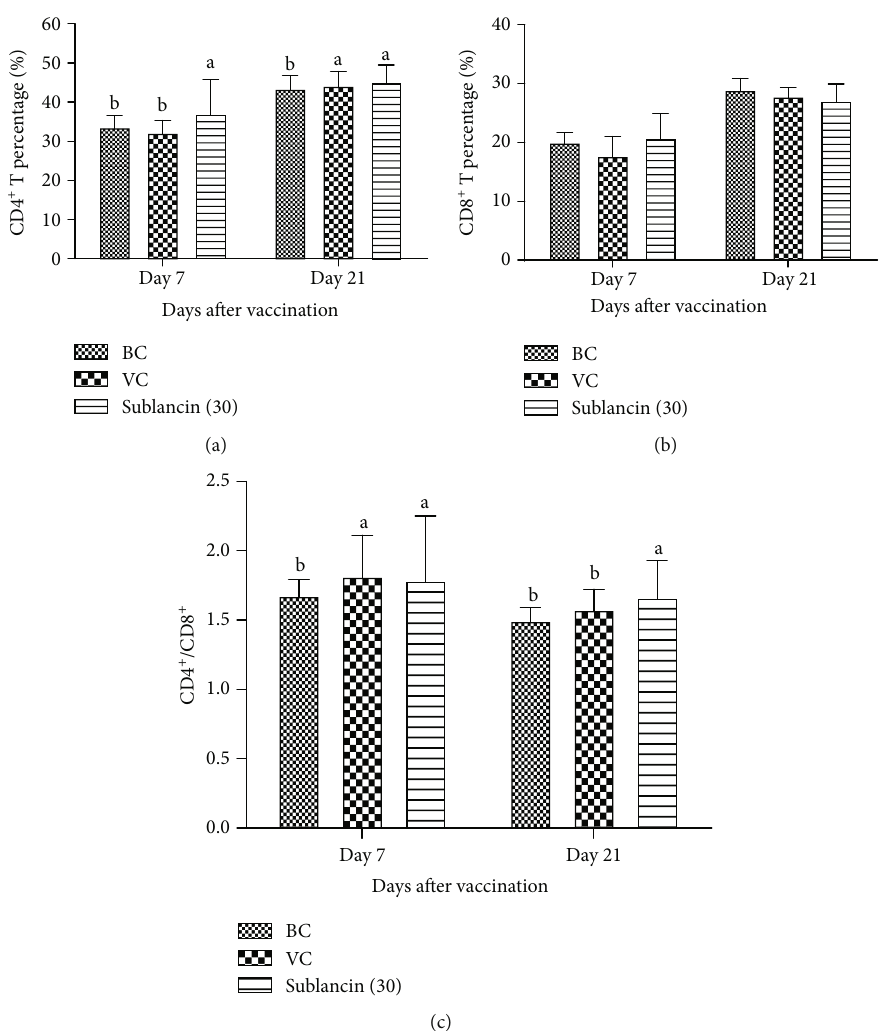
Figure 5: The dynamic changes of CD4 + , CD8 + , and CD4 + /CD8 + T lymphocyte subpopulations in each group in Exp. 3. a,b Bars in the same day without the same superscripts di ff er signi fi cantly ( P < 0 : 05